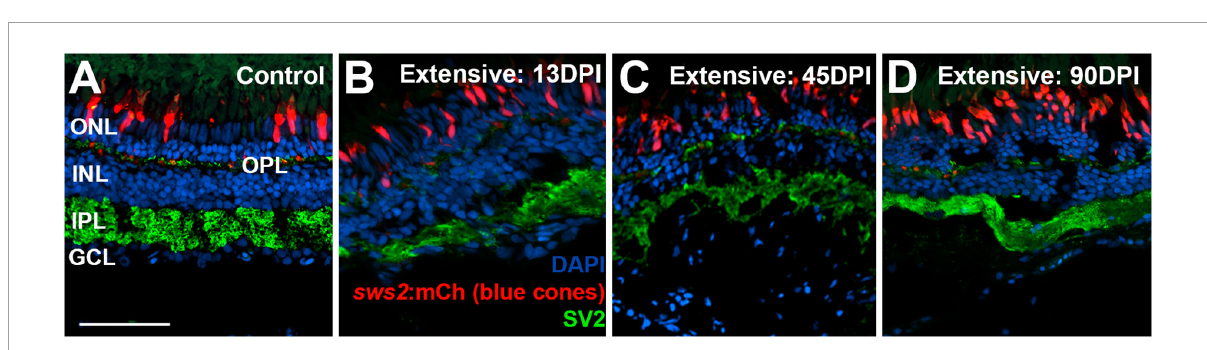
FIGURE7 Time-course of restoration of SV2 + plexiform layers following extensive lesion. Tissues were processed for indirect immunofluorescence and imaging after ERG recordings. (A) Control retina showing SV2 staining within the outer plexiform layer (OPL) and inner plexiform layer (IPL). (B–D) Regenerating retinas at 13 (B) , 45 (C) , and 90 days post-injury (DPI) (D) . SV2 staining is visible but disorganized within an emerging OPL and IPL at 13 DPI (B) , but displays improved lamination at 45 and particularly at 90 DPI (C,D) . ONL, outer nuclear layer; INL, inner nuclear layer; GCL, ganglion cell layer; scale bar (in A , applies to all) = 50 µ